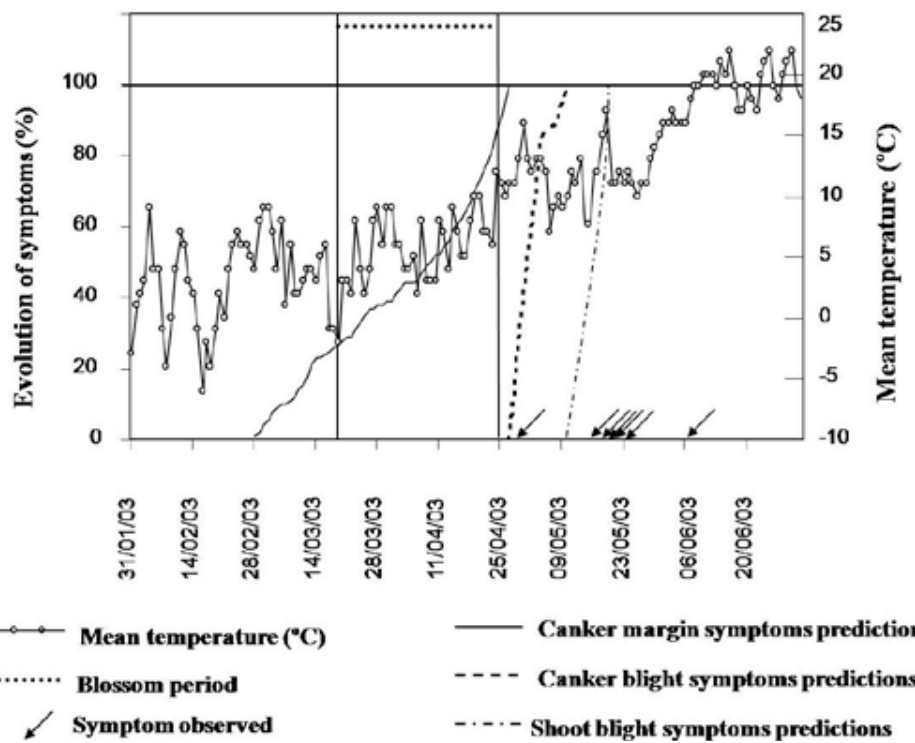
Figure 3. Fire blight risk according to MARYBLYT model in orchard P6-1 during 2003 on pear cv. Blanquilla. The mean tem - perature, blossom period and dates when the symptoms were observed are presented. Predicted evolution of infections on canker and shoots corresponds to oblique lines that start when the infection begins and end when the symptoms appear, corresponding to 100% of symptom evolution (horizontal bar).